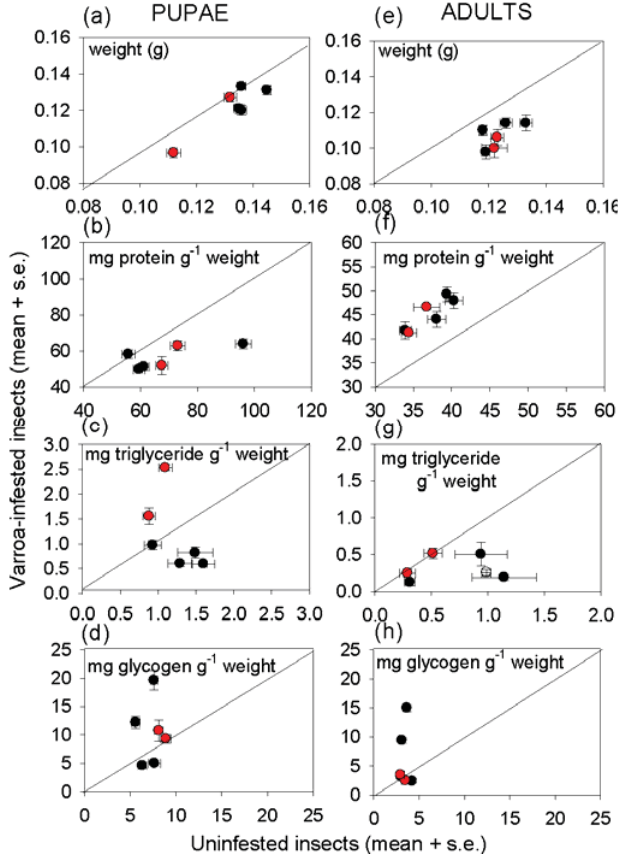
Figure 3. The weight and nutritional indices of uninfested and Varroa -infestedinsects (mean ± s.e, 12 replicates); with the diagonal line of equivalence; ( a-d ) showing nutritional conditions of pupae; and ( e-h ) newly emerged adult bees. Data for colonies with Varroa above the threshold for intervention are shown in red, and colonies below the threshold in black. The statistical analysis is shown in Supplementary Table